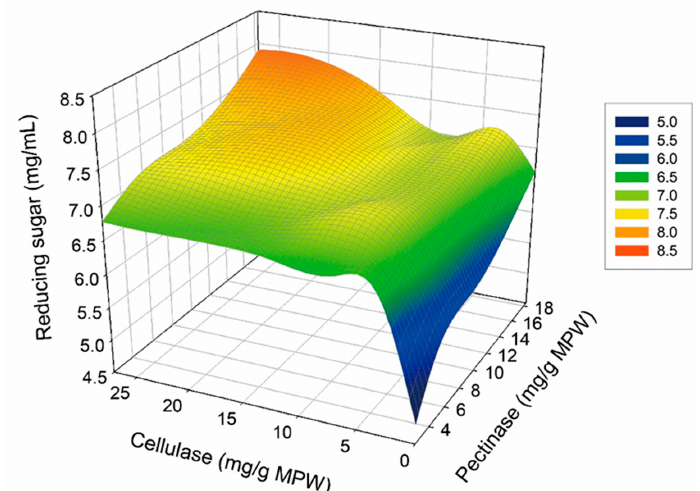
Figure 3. Response surface profile of reducing sugar concentration (mg/mL) under various of enzyme-loading